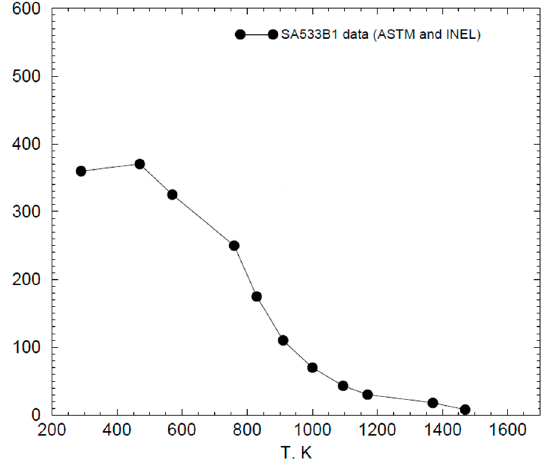
Figure 8. Yield stress trend as function of the temperature [6]. The strength halves at about 850